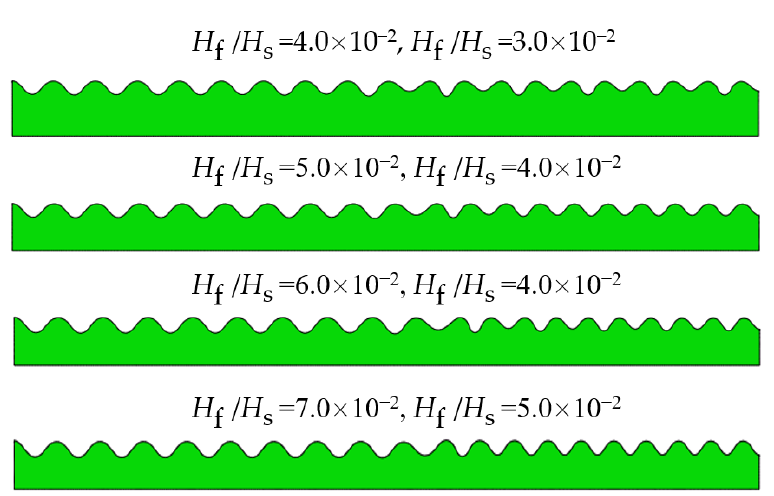
Figure 3. Influence of thickness ratio H f / H s on the composite instability